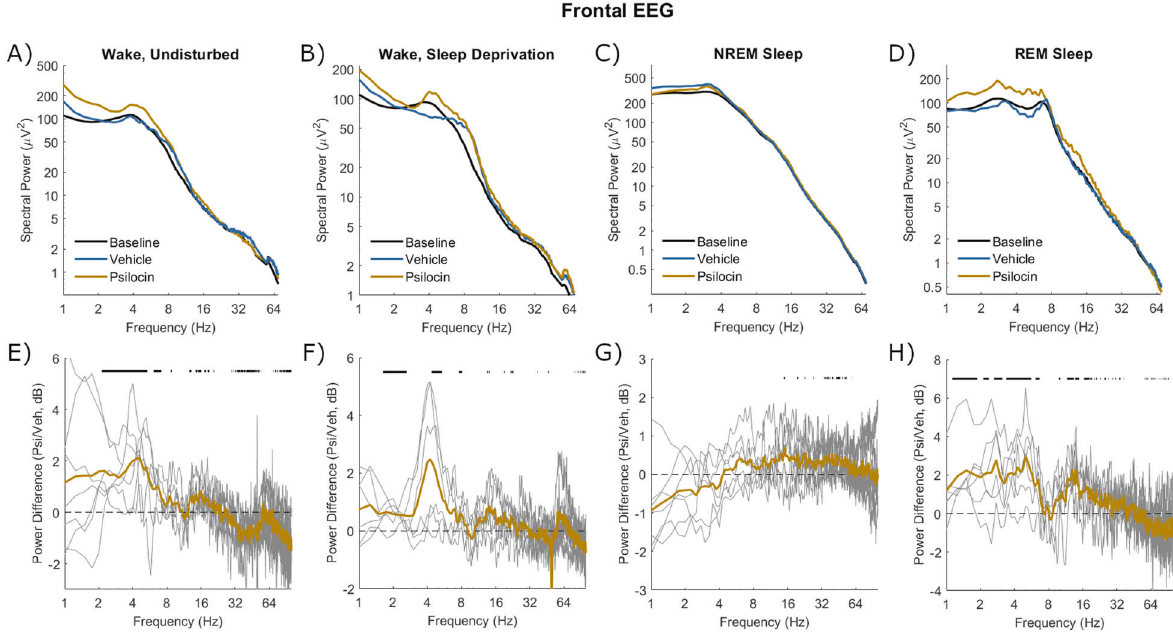
Fig. 5 Spectral power in frontal EEG after vehicle and psilocin injection. The mean power spectra of frontal EEG in four different vigilance state conditions following injection with vehicle (blue) and psilocin (yellow). A ) ‘ Wake, undisturbed ’ corresponds to the fi rst experiment, all wake epochs from injection until the fi rst NREM episode at least 1-minute duration. B ) ‘ Wake, sleep deprivation ’ corresponds to the fi rst 30 min of sleep deprivation in the second experiment. C ) ‘ NREM sleep ’ and D ) ‘ REM sleep ’ correspond to the fi rst experiment, all NREM/REM sleep epochs in the sleep period after injection, de fi ned from the start of the fi rst NREM sleep episode at least 1 min duration until the next wake episode at least 5 min duration. Spectra averaged across the same vigilance state in the baseline day are shown for comparison (black). E – H ) Below each plot illustrates the spectral power difference as a function of frequency in decibels between vehicle and psilocin conditions (positive is greater after psilocin). Grey lines correspond to individual animals and coloured lines to the mean. Black lines indicate discrete frequencies (at 0.25 Hz resolution) that were signi fi cantly different ( p < 0.05) according to paired t